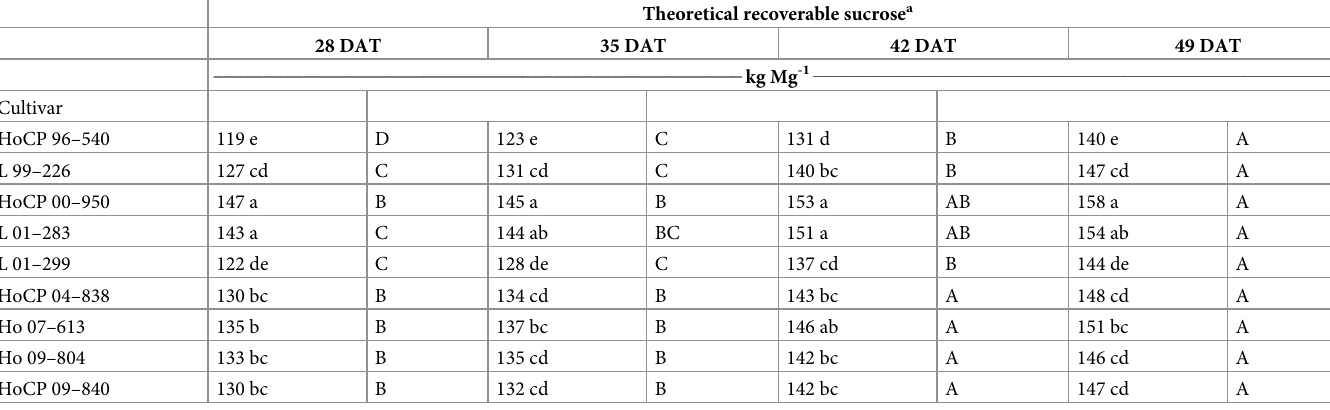
Table 5. Effect of sugarcane cultivar on theoretical recoverable sucrose from whole stalk samples at 28, 35, 42, and 49 days after treatment (DAT) in 2016 and 2017 at Schriever,